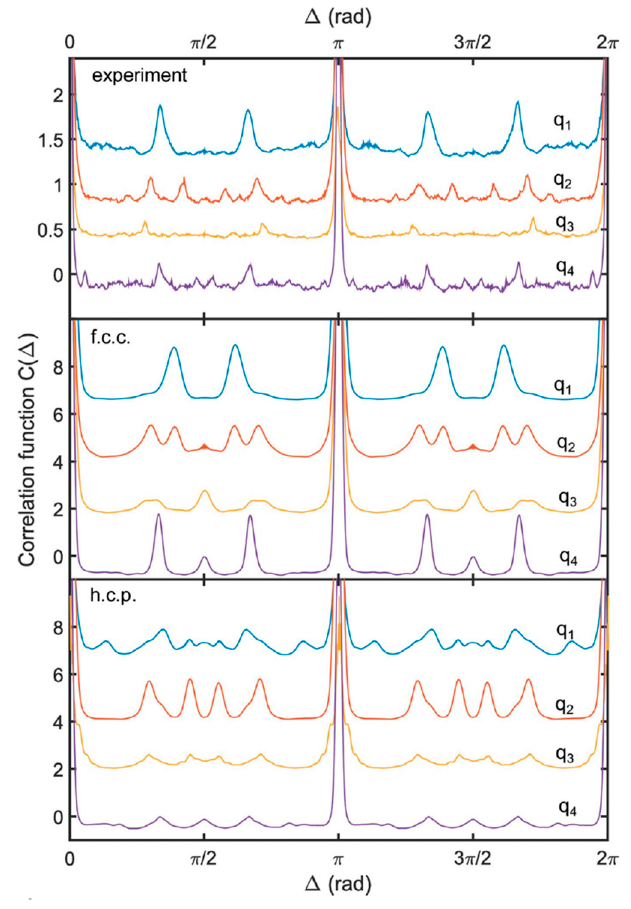
Figure 13. Experimentally measured cross-correlation function (CCF) 𝐶(q, Δ) at four different values of the momentum transfer q 1 = 0.027 nm − 1 , q 2 = 0.029 nm − 1 , q 3 = 0.031 nm − 1 , q 4 = 0.044 nm − 1 (top) and modelled CCFs assuming ideal face-centered cubic (fcc) (middle) and hexagonal close-packed (hcp) (bottom) structures. Curves are shifted vertically for better visual appearance. (adopted from [85]). Used under CC-BY 4.0.